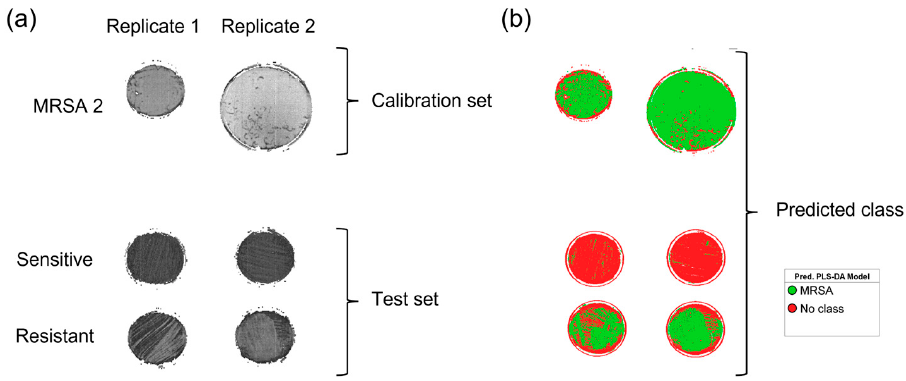
Figure 5. PLS-DA image showing calibration samples used to build the model and test samples that were excluded for model validation ( a ). The predictions show test samples assigned to resistance that correspond to the generated images ( b ).